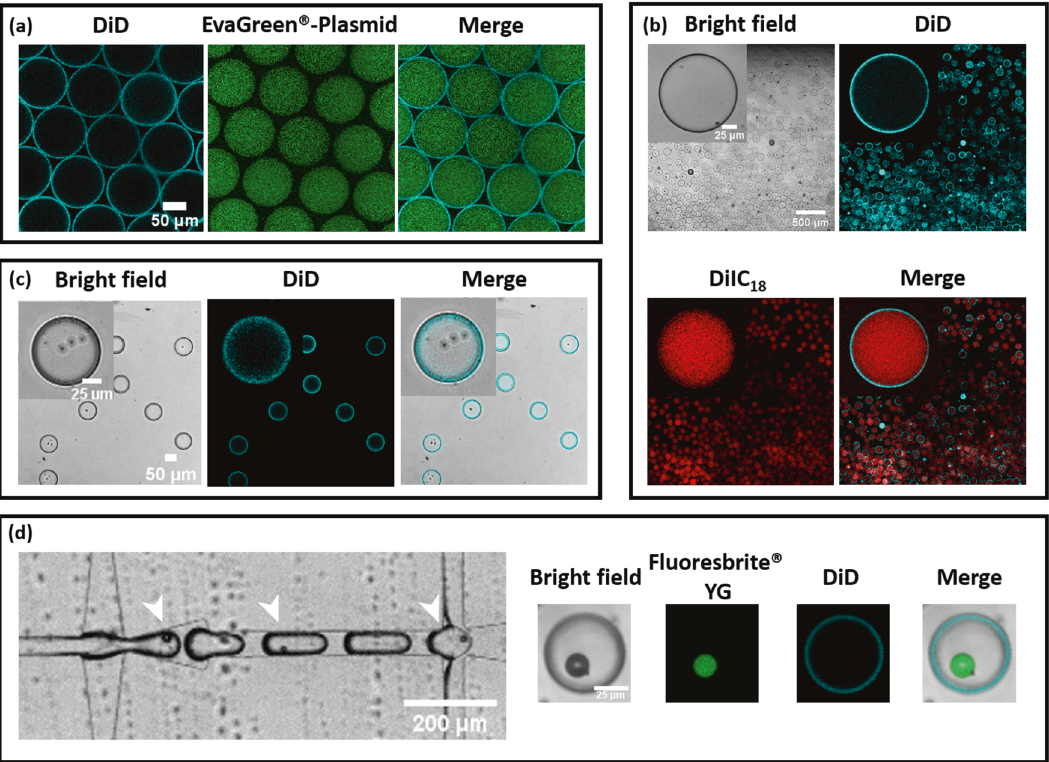
Fig. 5 Micro fl uidic production of arti fi cial cells. a Encapsulating EvaGreen ® -plasmid DNA, b showing compartmentalization with SUVs, c encapsulating fi broblast cells along with the culture media, and d encapsulating microplastics such as styrene